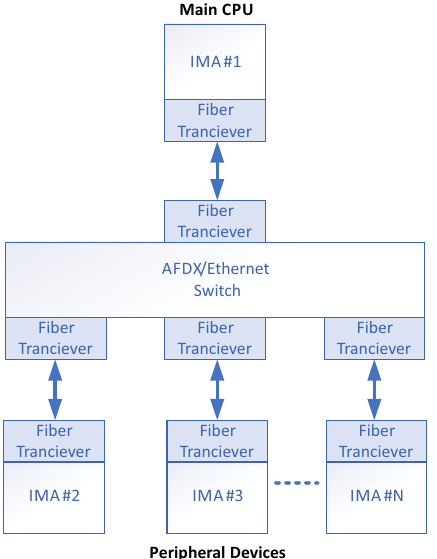
Figure 12. Topology of the classical optical onboard